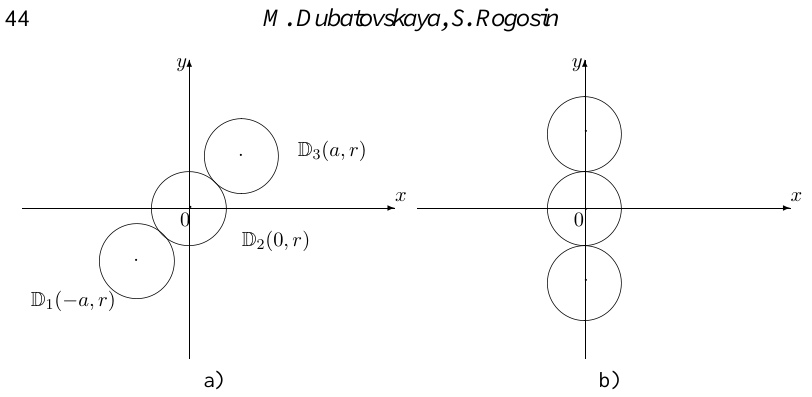
Figure 4. Arrangement of discs: a) three discs in line, b) three discs in line along imaginary